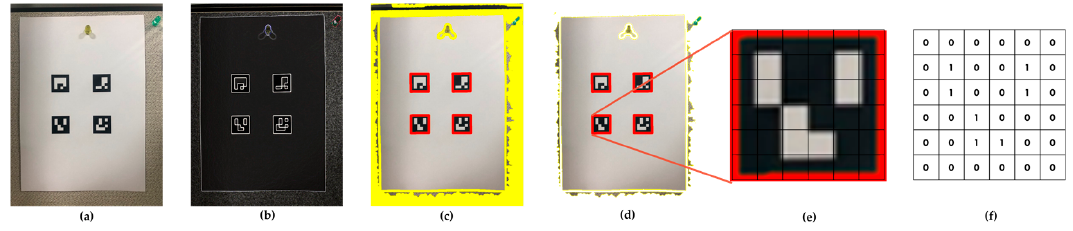
Figure 3. Process for automatic marker detection in an image: ( a ) original image; ( b ) result of applying local thresholding; ( c ) contour detection; ( d ) polygonal approximation and removal of irrelevant contours; ( e ) example of marker after perspective transformation; ( f ) bit assignment for each cell. [40].